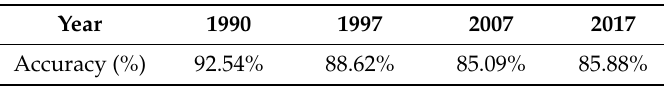
Table 2. Accuracy of Local Climate Zone’s (LCZ’s) validation.